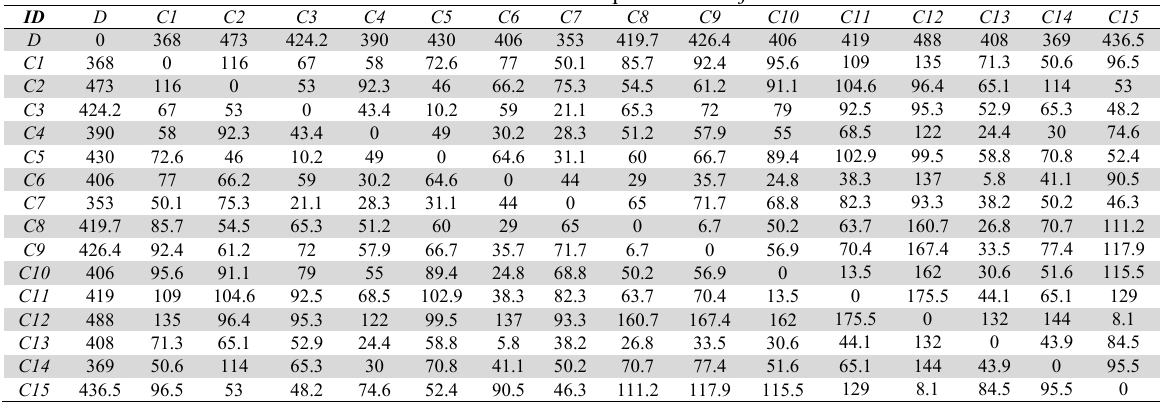
The actual distance matrix from the candidate seed node i to the petrol station